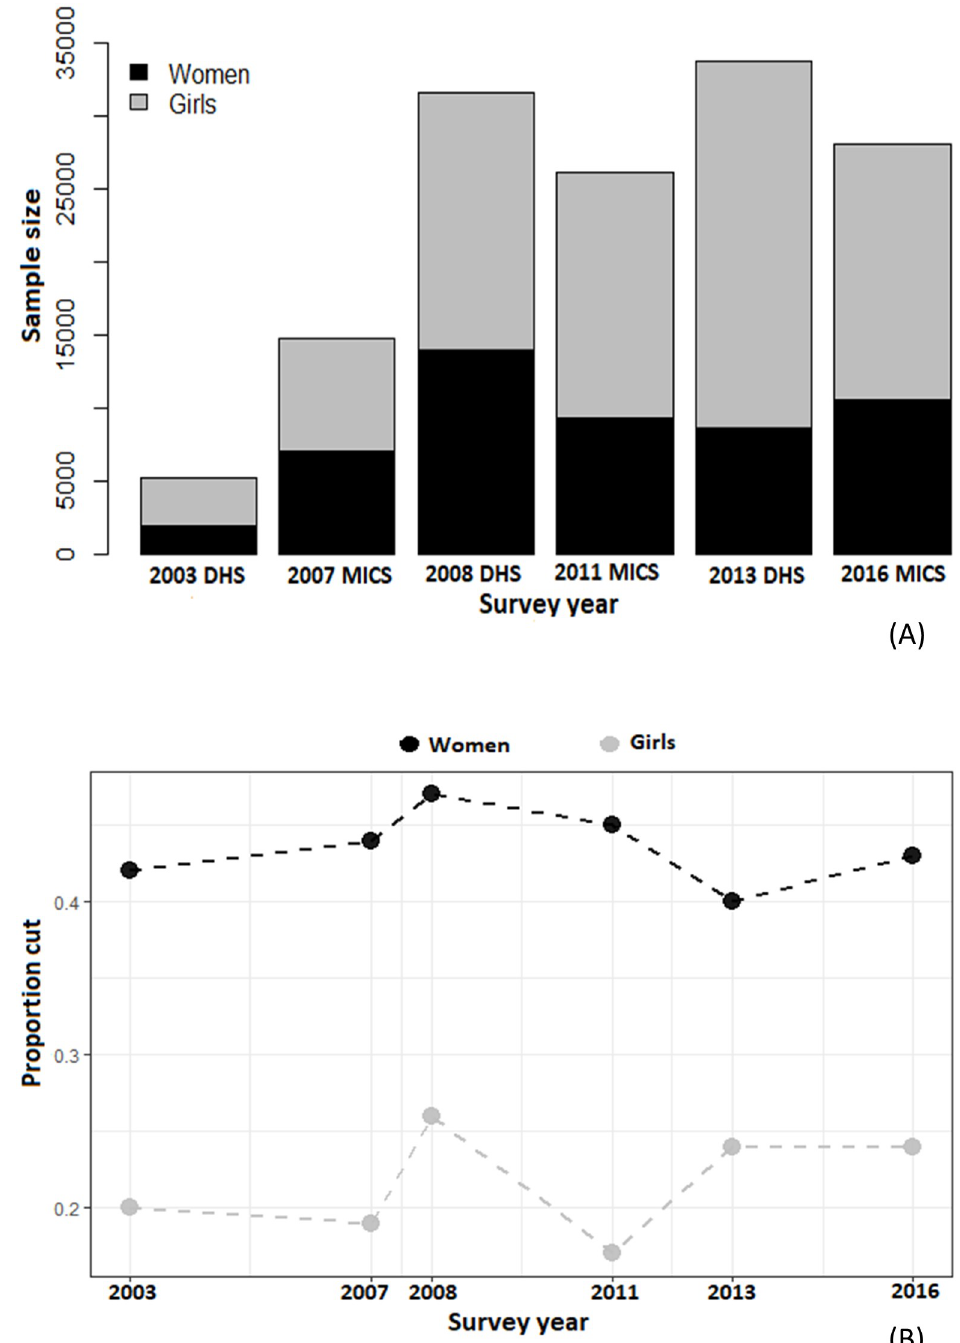
Fig 2. Data presentation. (A) Sample size distribution of women (aged 15–49 years) and girls (aged 0–14 year) across the Nigeria DHS and MICS surveys from 2003 to 2016. (B) Proportion of cut women and girls across the datasets.